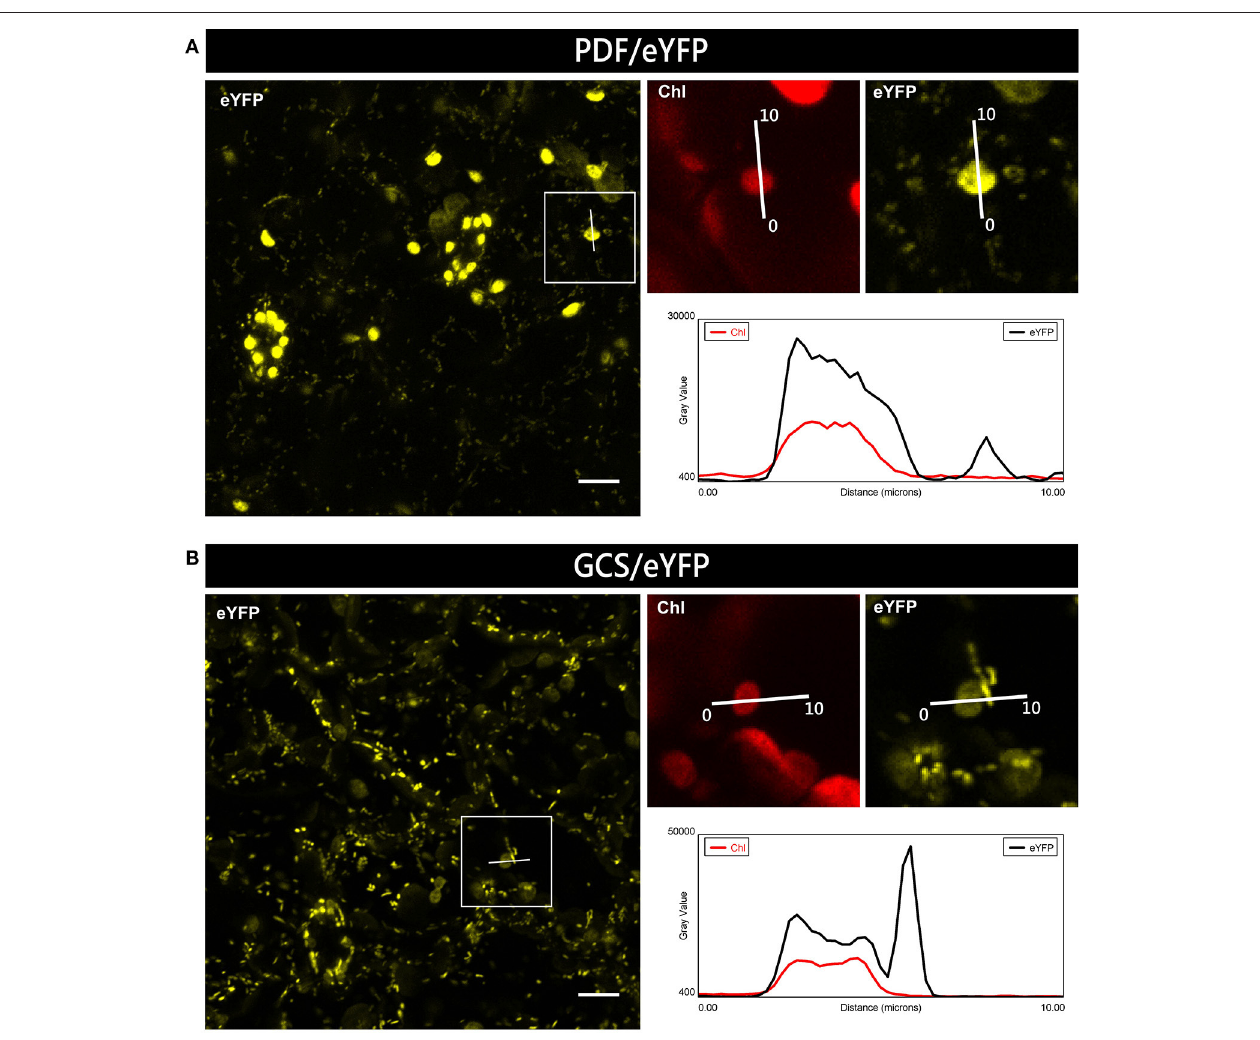
FIGURE 6 | Preferential organellar accumulation of candidate proteins in transgenic Arabidopsis plants. Leaf epidermal cells of transgenic Arabidopsis thaliana plants constitutively expressing PDF/eYFP (A) or GCS/eYFP (B) show preferential accumulation of the fluorescent reporter protein in plastids and mitochondria, respectively. To compare the relative signal strengths in the two organelles, the degree of fluorescence was quantified using the plot profile tool of Fiji along a single line of 10 µ m, covering in each case both a plastid and a mitochondrion. In the resulting graphs, gray value represents fluorescence intensity of the eYFP signal ( black line ) and the chlorophyll signal ( red line ). For further details see the legend of Figure 1